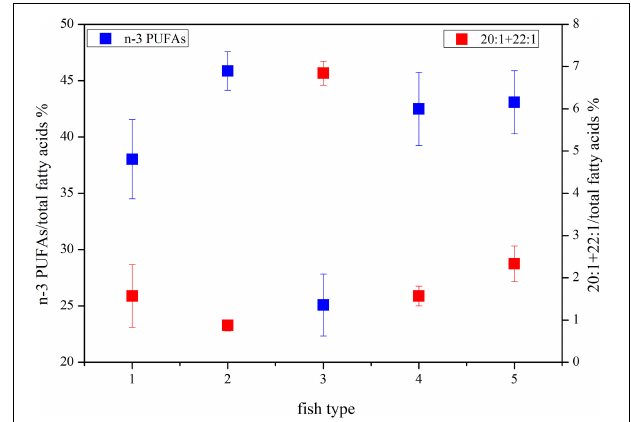
FIGURE 2 | Some characteristic fatty acid combinations of the different fish groups (group 1, migrant planktivorous fishes; group 2, migrant piscivorous fishes; group 3, non-migrant planktivorous fishes; group 4, non-migrant piscivorous fishes; group 5, semi-migrant piscivorous fishes).